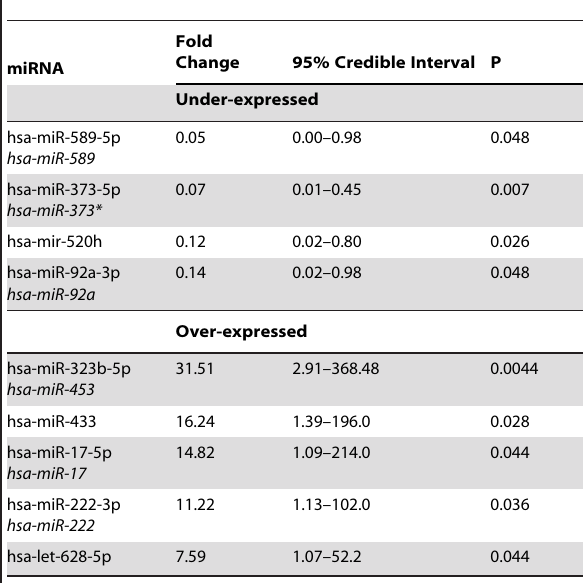
Table 3. Incremental differential expression of miRNAs between albuminuric samples from patients with persistent microalbuminuria (PMA) relative to patients with intermittent microalbuminuria (IMA).